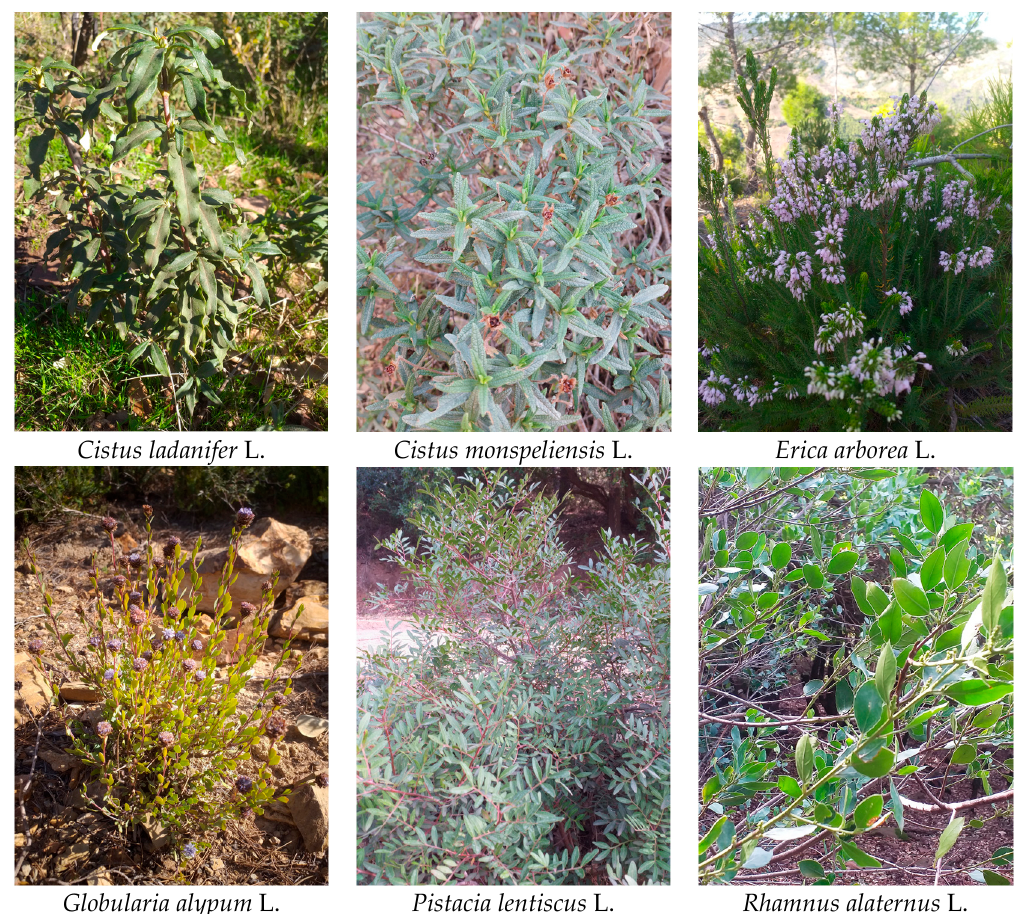
Figure 4. The selected medicinal plants in their natural habitat (the photographs taken by Dr. Leila Gadouche).